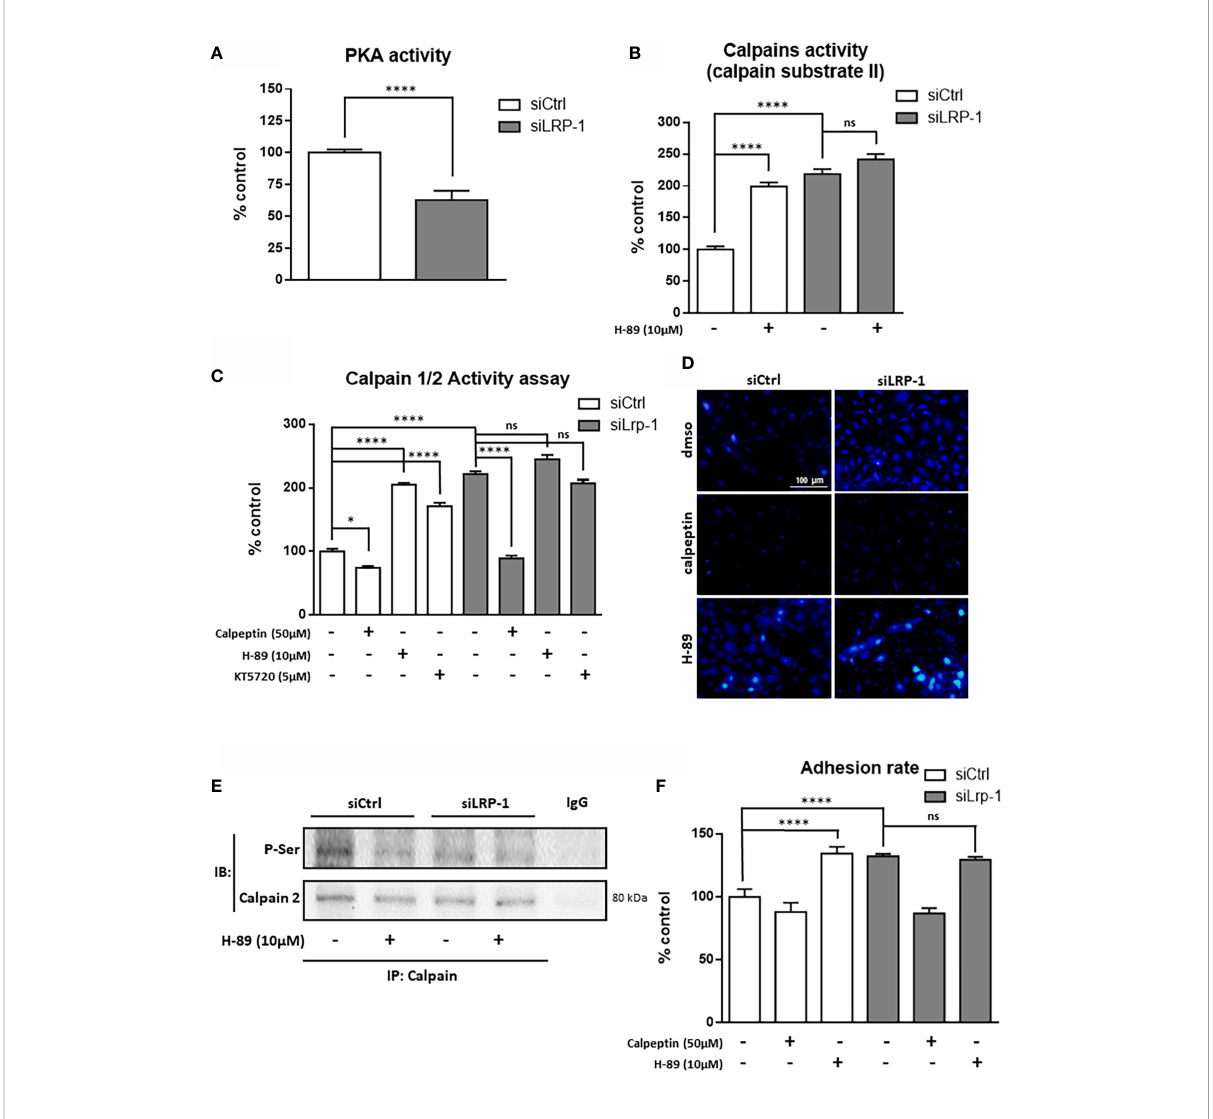
FIGURE 5 LRP-1-dependent PKA signaling limits CAPN2 activity. PKA activity was measured in whole extracts of FTC133 cells transfected with siRNA sequences and cultivated 3 hours on gelatin-coated dishes by using the fl uorigenic ProFluor PKA enzymatic assay (Promega), adapted to measure speci fi cally PKA activity in raw cellular extracts (A) . Extracts from FTC133 cells, treated with 10µM H-89 (PKA inhibitor) or vehicle, were used to measure the calpain speci fi c degradation of the fl uorigenic calpain substrate II (B) . Same extracts were used to test the impact of PKA on calpain activity measured by the Calpain ½ Activity Assay Kit in presence or absence of 50µM of calpeptin, 10µM of H-89 or 5µM of KT5720 (C) . Calpains-speci fi c release of CMAC from calpains substrate BOC-LM-CMAC was analyzed in intact cells after treatment with calpeptin of H- 89 (D) . Whole-cell extracts were isolated from FTC133 cells treated with 10µM H-89. Co-immunoprecipitation of calpain-2 were performed and phosphorylation status of the protease was analyzed by SDS-PAGE and immunoblotting using an antibody reacting with phosphorylated serine residue (E) . FTC133 cells transfected with siCtrl or siLRP-1 RNA were seeded onto gelatin coated plates in presence or absence of calpeptin or H-89 and the non-adherent cells were washed out after 60 minutes (F) . Results are representative of at least 3 independent experiments and are expressed as mean percentage from a minimum of 4 internal replicates standardized to control value. ns, not signi fi cant; * P < 0,05, ****, P <